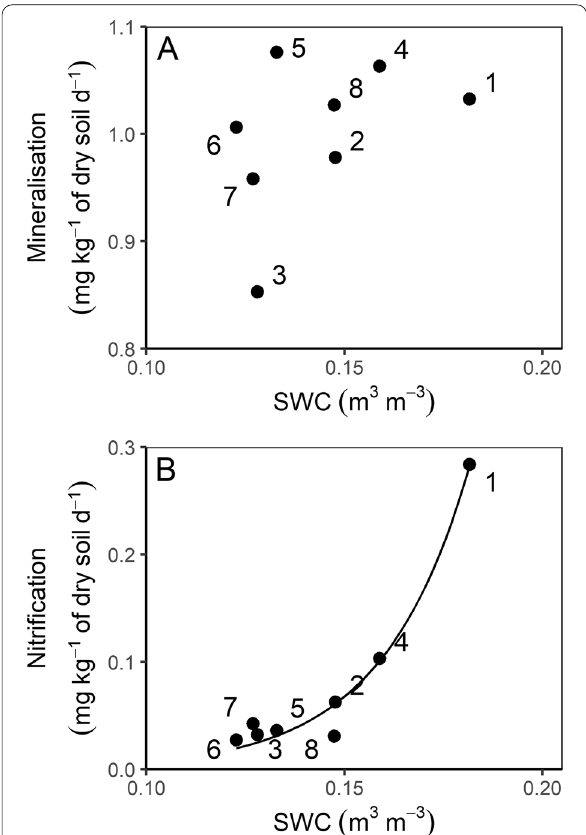
Fig. 4 Relationships between the mean stand values ( n soil water content (SWC) and A nitrogen mineralisation and B